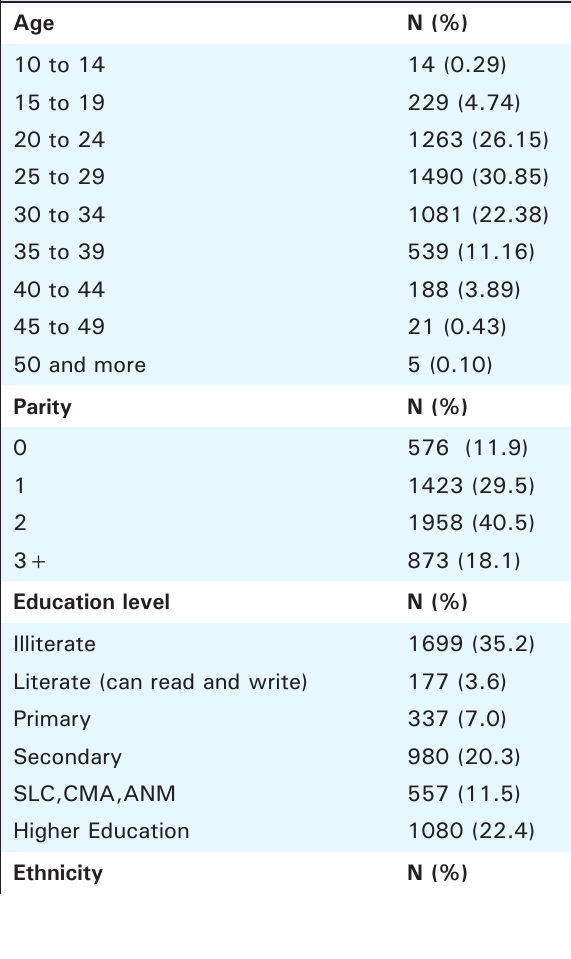
Table 1. Percentage distribution of variables in the sample